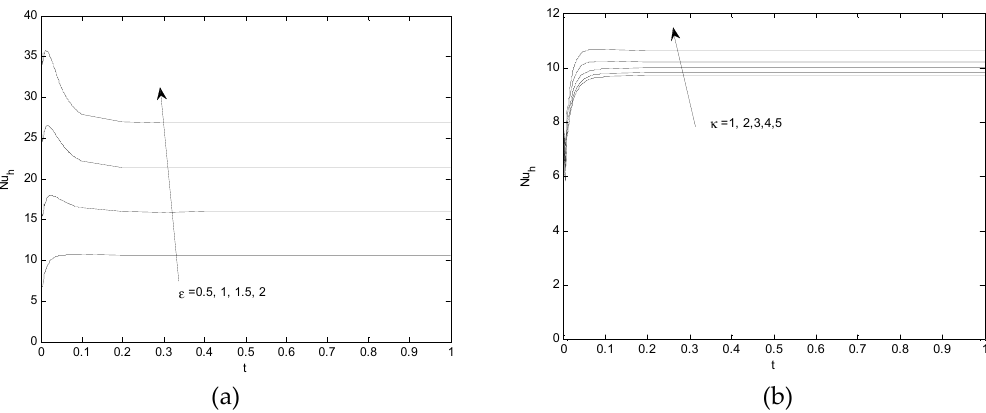
Figure 7. Time profiles of the average Nu for the heated border at Ra = 10 6 , Pr = 7, ϕ = π /3: ( a ) various ε and κ = 1; ( b ) various κ and ε = 0.5. Energies 2019 , 12 , 1461